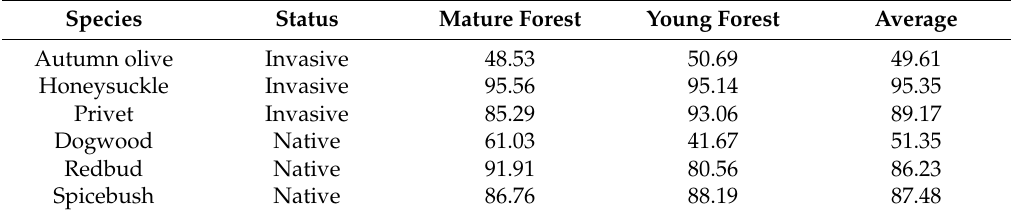
Table A2. Average percentage of seedlings of each species surviving after three years (to 2006) in mature and young